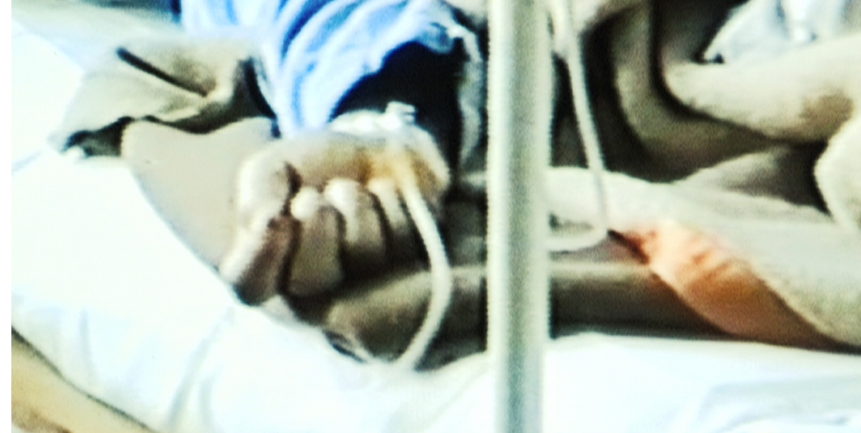
Fig. 5. Still from the documentary-poetry film Bridges <Bosnia 20>